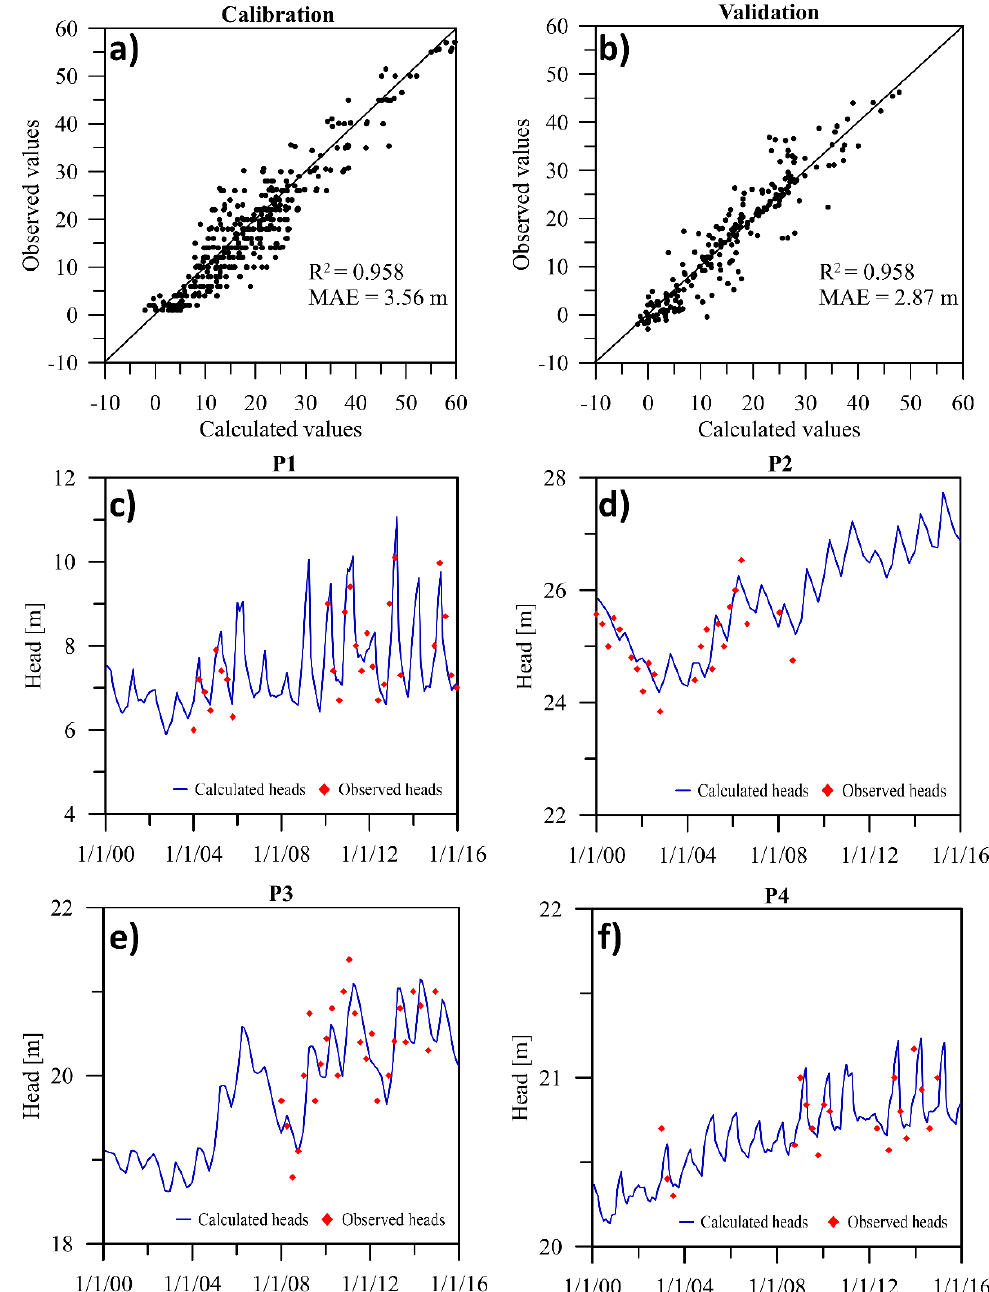
Figure 3. Head Scatter Diagrams of the calibration ( a panel ) and validation processes ( b panel ), and comparison between calculated and observed heads at piezometers P1, P2, P3 and P4 ( c – f panels ), represented in Figure 1.